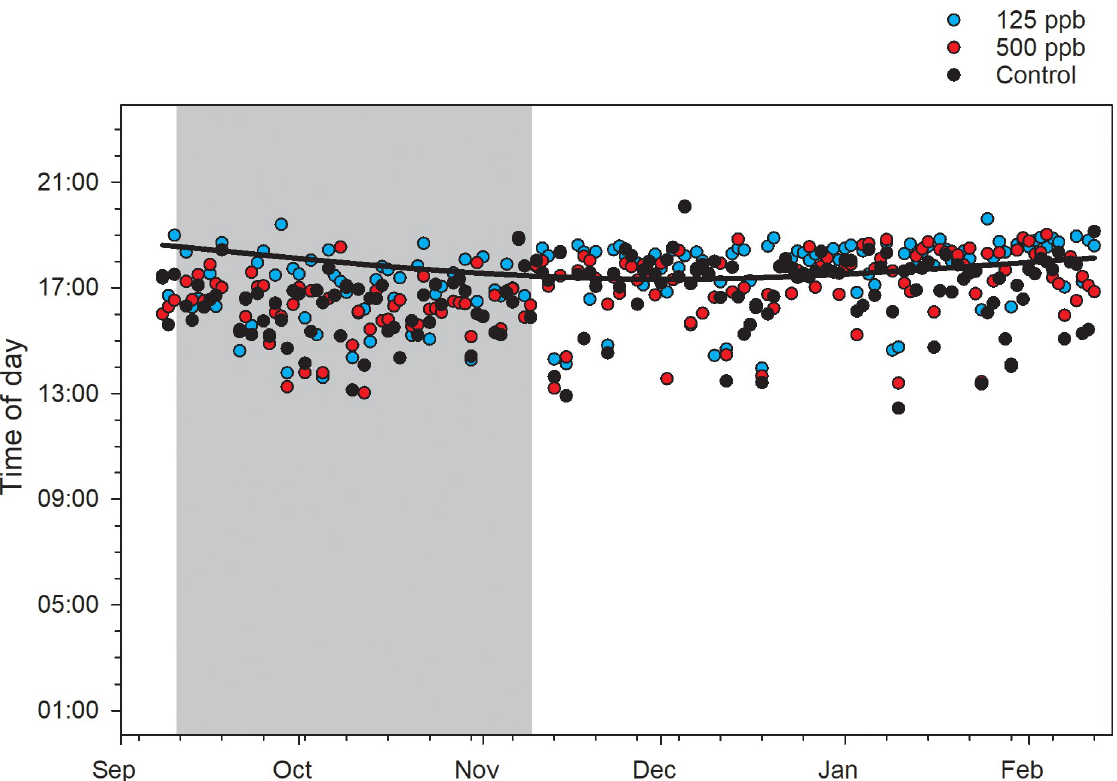
Fig 2. Break points associated with the end of daily activity of bee colonies. The points were obtained using piecewise regression of within-day hive weight changes for the Fall 2017 experiment. Gray area shows the treatment period. Solid black horizontal line shows calculated sunset